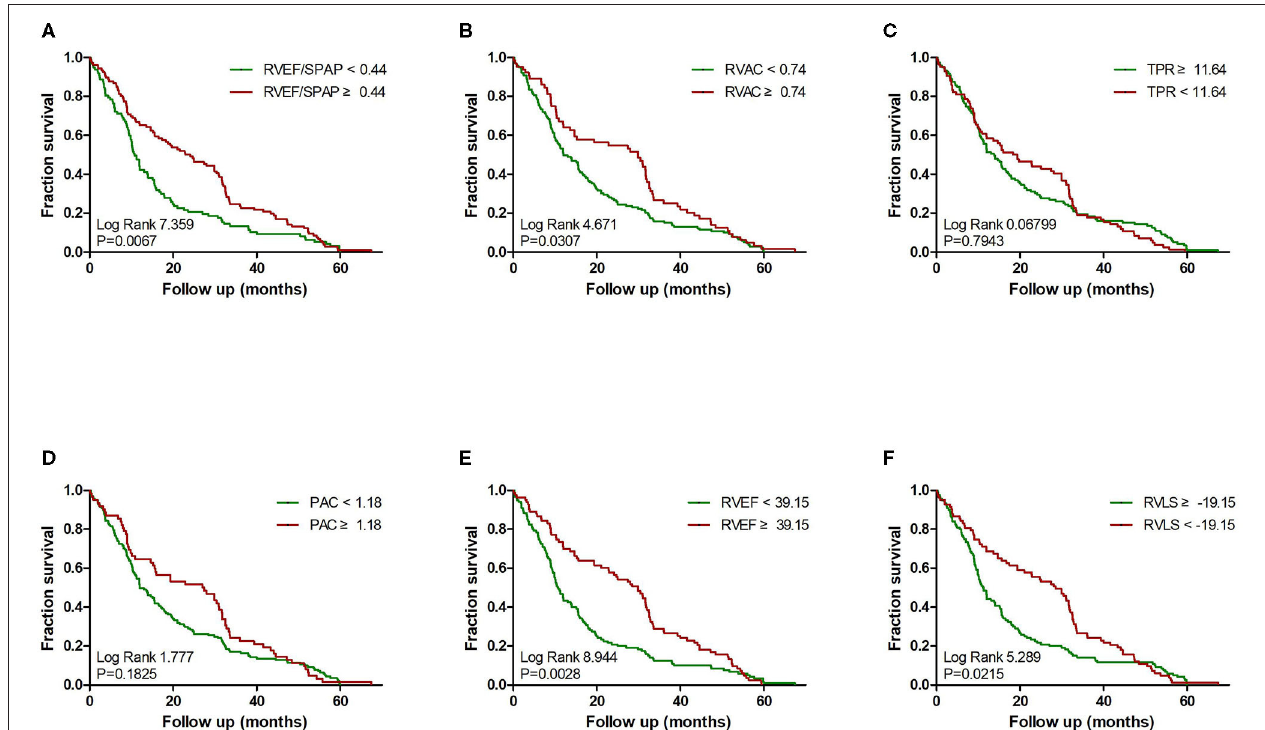
FIGURE 3 | Impact of RV function indices and RV coupling to pulmonary circulation on clinical failure in precapillary PH. Kaplan–Meier survival analysis for precapillary PH patients with: (A) RVEF/PASP < 0.44 and ≥ 0.44; (B) RVAC < 0.74 and ≥ 0.74; (C) TPR < 11.64mm Hg/ml and ≥ 11.64mm Hg/ml; (D) PAC < 1.18 ml/mm Hg and